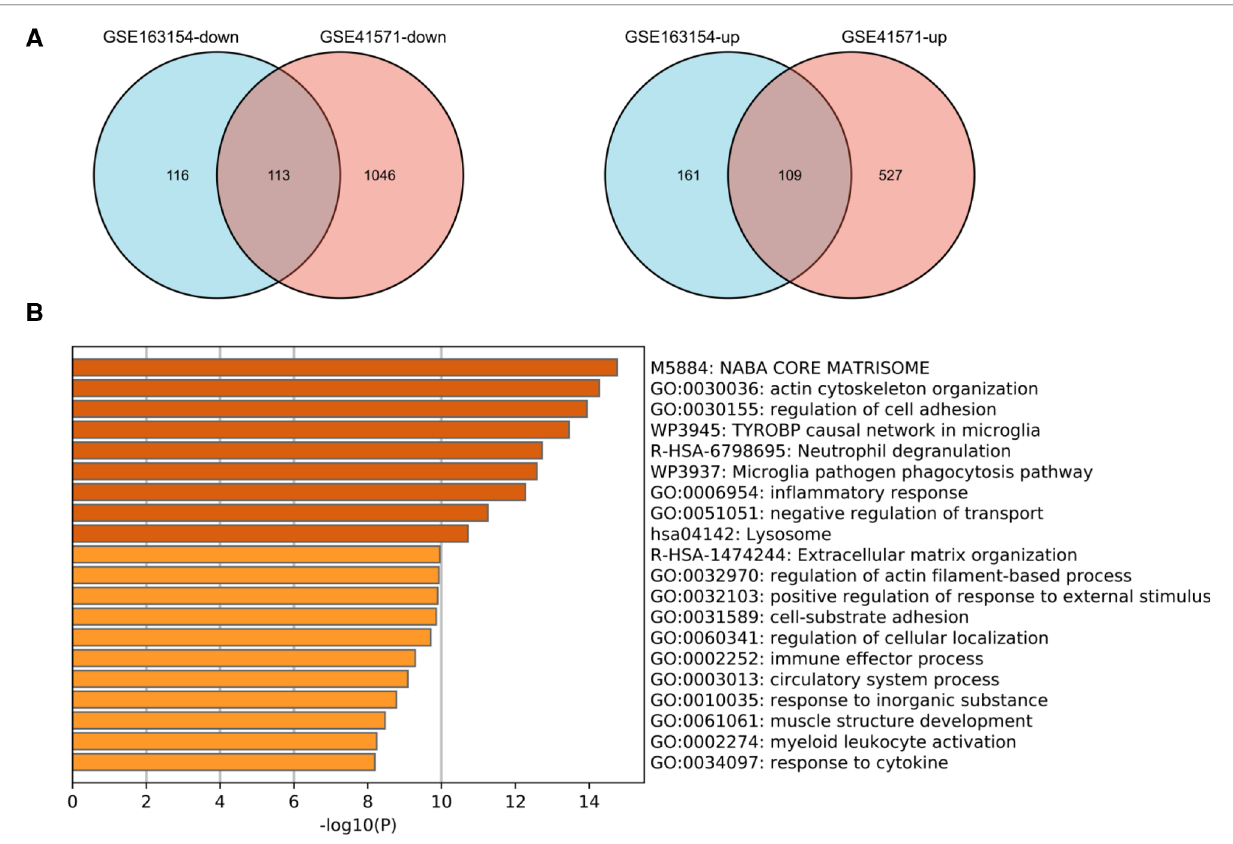
FIGURE 5 Functional enrichment analysis of shared DEGs in the validation cohort. ( A ) Venn diagram showed the 222 DEGs overlapped between GSE163154 and GSE41571, which were de fi ned as SET2, including 113 downregulated genes and 109 upregulated genes. ( B ) Signaling pathways enriched in SET2. DEGs, Differential Expression